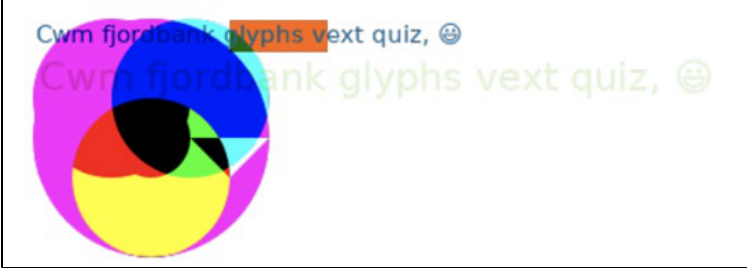
Figure 4. The rendered image in Fingeprintjs2′s canvas fingerprinting.